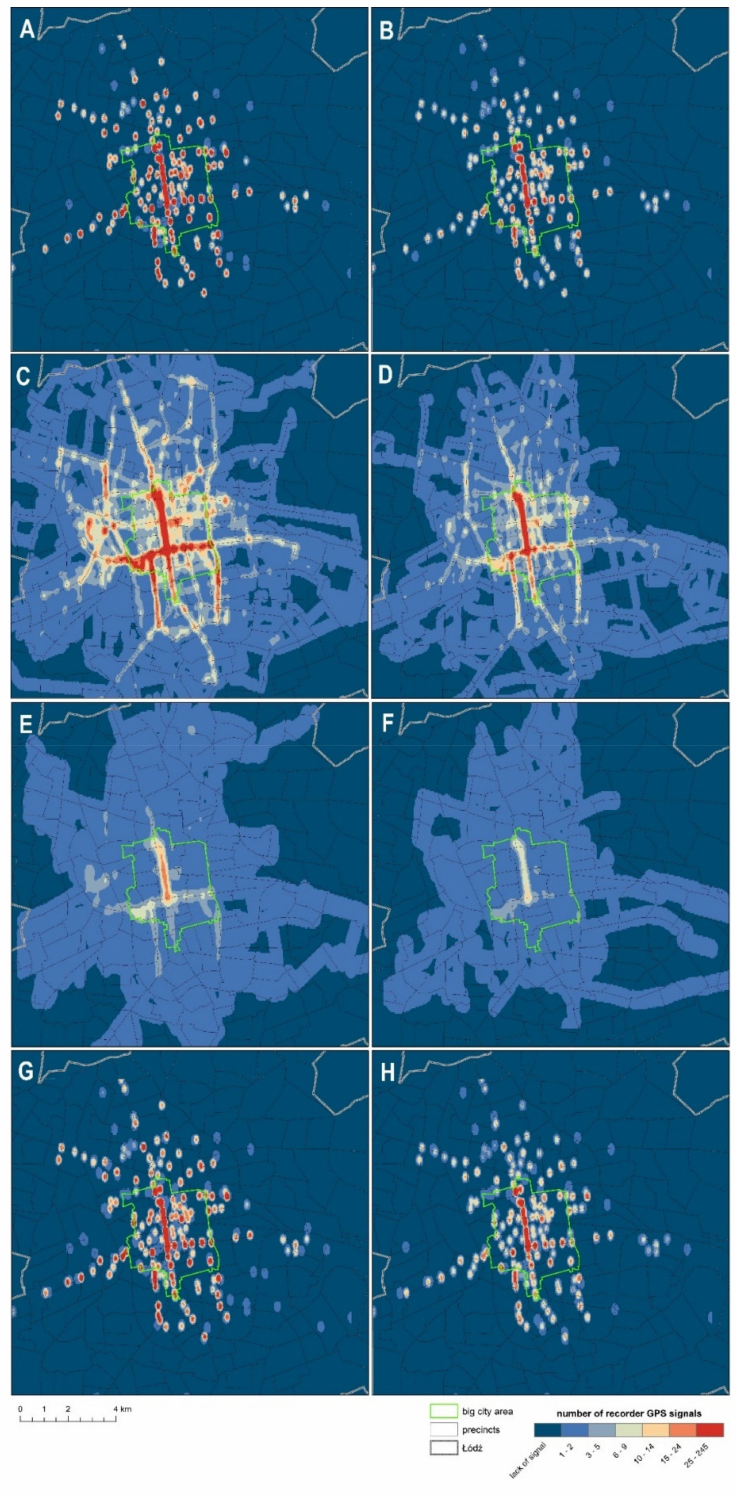
Figure 12. Differentiation of the ŁPB traffic density on non-trading ( A , C , E , G ) and trading ( B , D , F , H ) Sundays at the start of the trip ( A , B ), during the trip ( C , D ), at peak hours ( E , F ), and at the end of the trip ( G , H ) in Ł ó d´z in 2018. Source: own elaboration based on data from the Ł ó d´z City